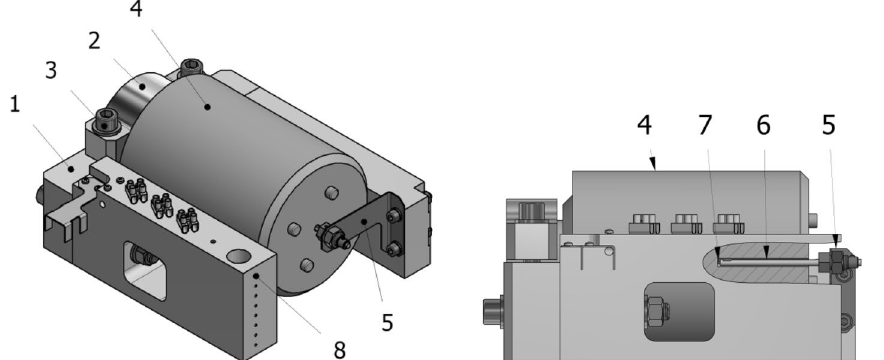
Figure 5. View and section of the gearset holder.